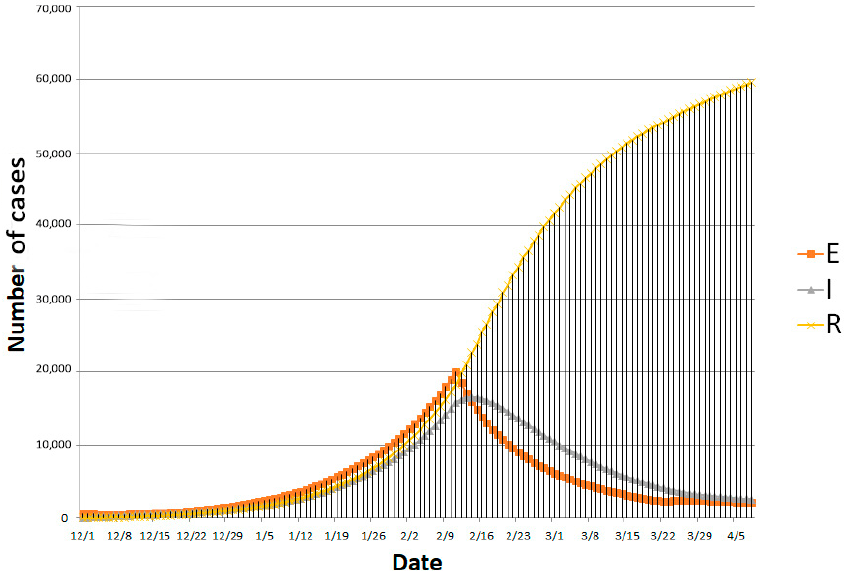
Figure 5. SEIR model simulation outputs from 1 December 2019, to 8 April 2020.